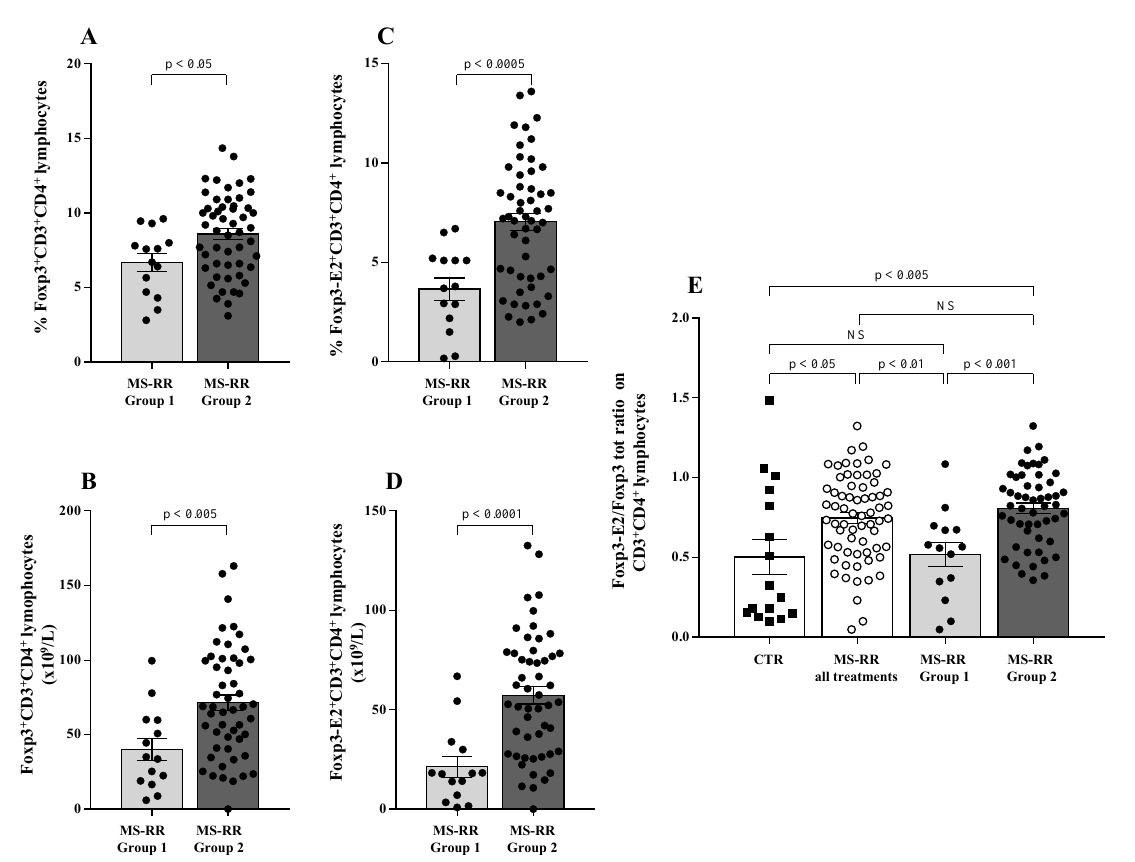
Figure 6. Higher SOD-1 content in circulating T cells of MS-RR individuals was associated with significant increase of Treg-expressing Foxp3-E2. Light grey column with black dots represents the MS-RR Group 1 subjects; dark grey column with black dots indicates the MS-RR Group 2 individuals. ( A , B ) Intranuclear Foxp3 transcription factor expression in CD4 + T lymphocytes. ( C , D ) Foxp3-E2 transcription factor expression in CD4 + T lymphocytes. ( E ) Comparative analysis of Foxp3-E2/whole Foxp3 ratio in the MS-RR cohort (white column with white dots) versus healthy controls (white column with black squares). Statistical evaluation of data was performed by means of the Mann–Whitney